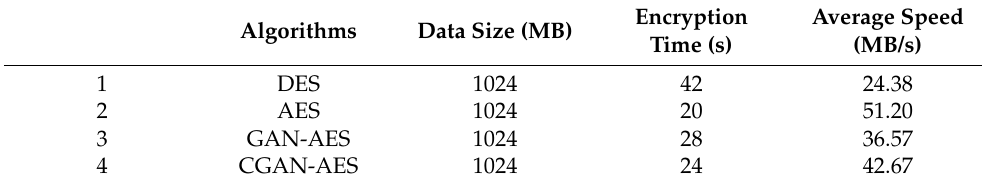
Table 2. Efficiency verification of different algorithms.